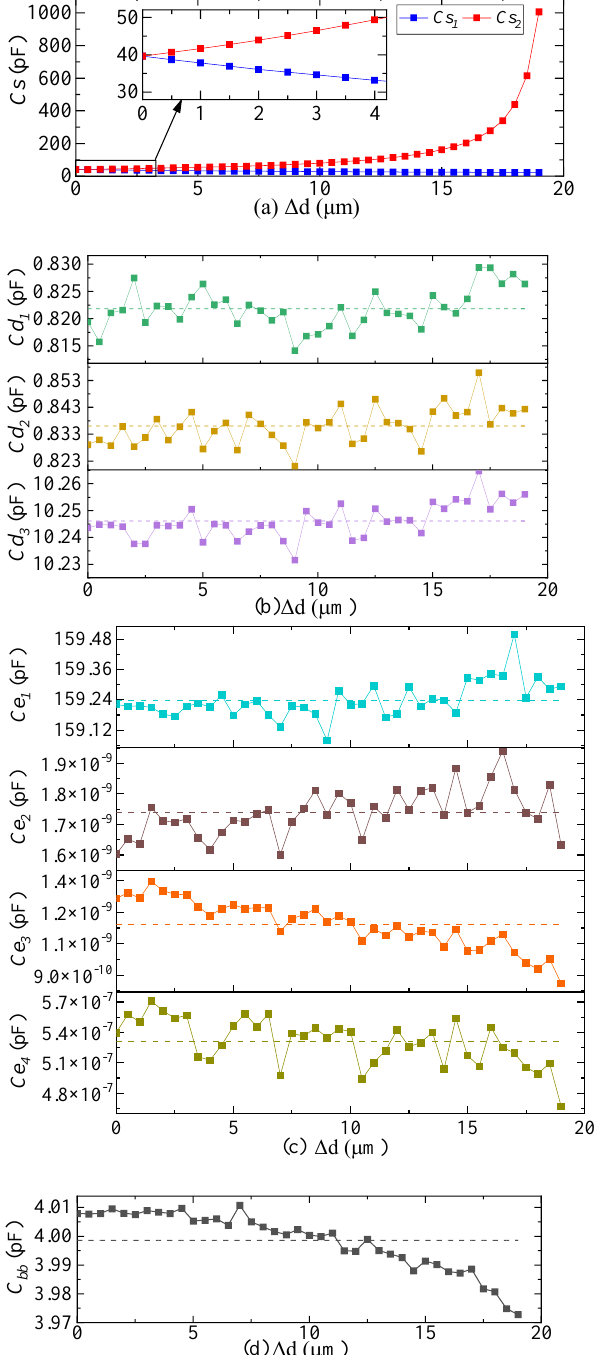
Figure 3. Simulation results of differential capacitance and distributed capacitance. ( a ) Simulation results of differential capacitance 𝐶 𝑠1 and 𝐶 𝑠2 ; ( b ) Simulation results of distributed capacitance 𝐶 𝑑1 , 𝐶 𝑑2 , and 𝐶 𝑑3 ; ( c ) Simulation results of distributed capacitance 𝐶 𝑒1 , 𝐶 𝑒2 , 𝐶 𝑒3 , and 𝐶 𝑒4 ; ( d ) Simulation results of distributed capacitance 𝐶 𝑏𝑏 .